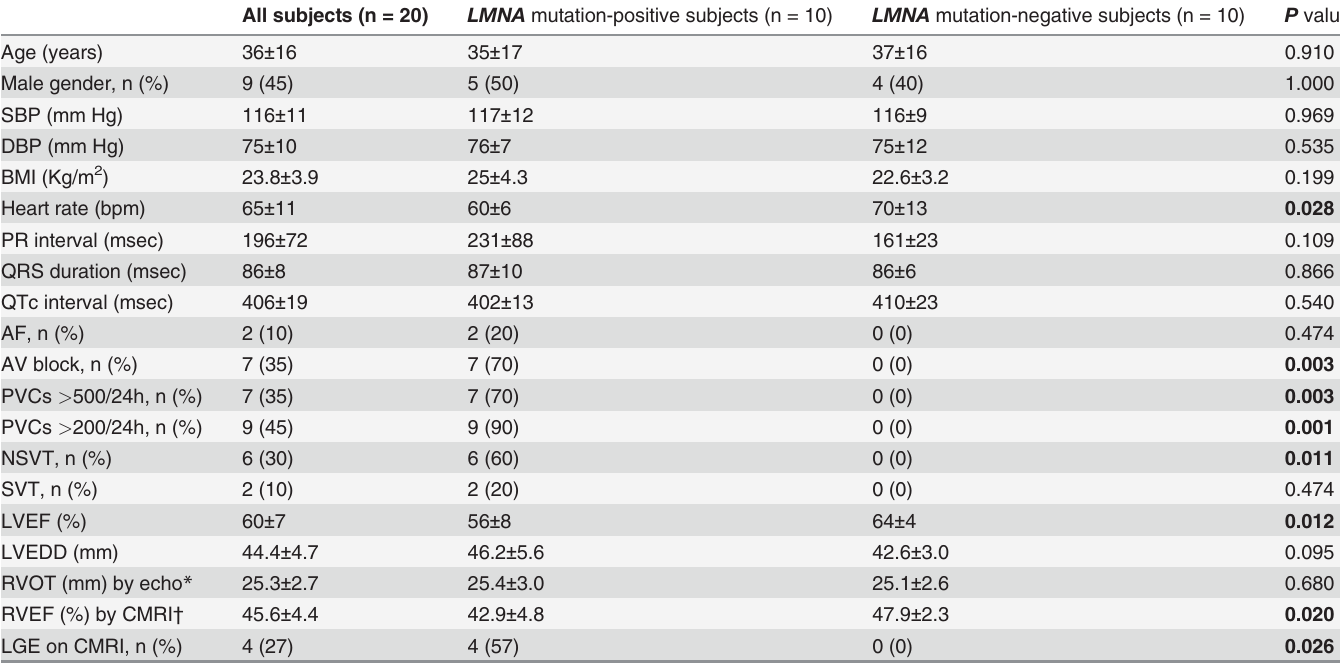
Table 1. Clinical characteristics of family members according to LMNA mutation carrier